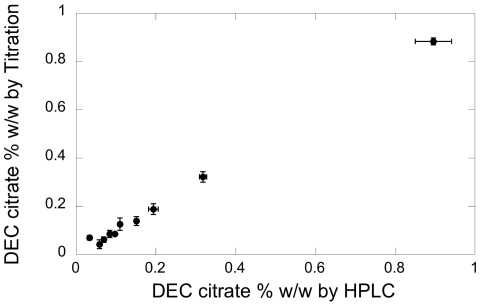
Comparison of back-titration and HPLC concentration determinations.Error bars show standard deviation of triplicate measurements. For low concentration samples, error bars in HPLC measurement are very small.